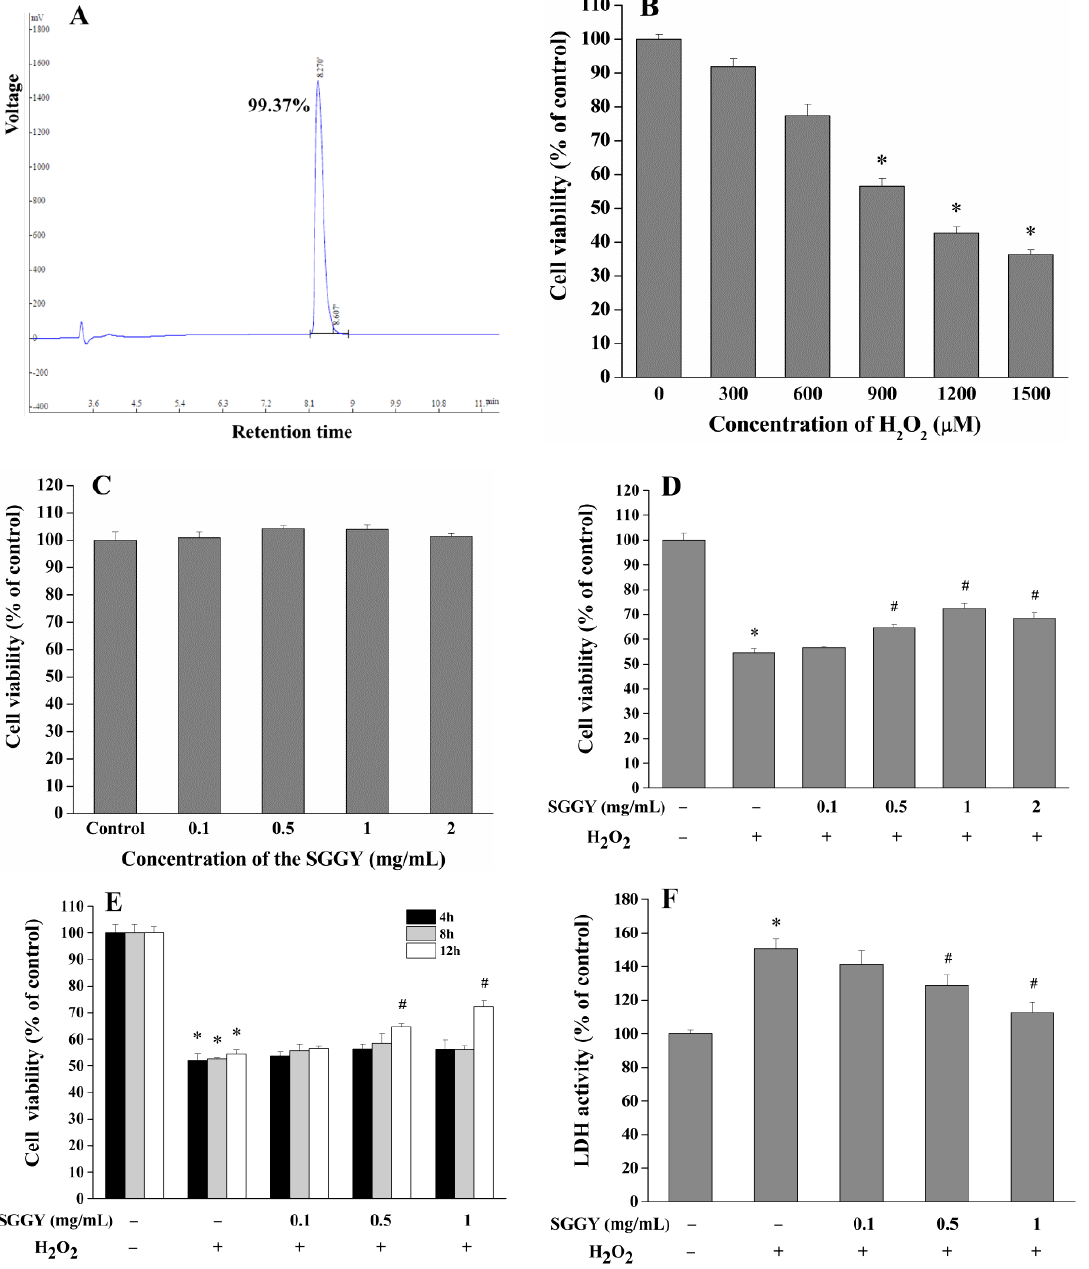
Figure 1. SGGY suppressed H 2 O 2 -triggered cytotoxicity in SH-SY5Y cells. ( A ) Purity of SGGY. Cells were treated for 2 h with ( B ) various concentrations of H 2 O 2 , or for 12 h with ( C ) different concen- trations of SGGY, and subsequently, the cell viability was determined using the MTT assay. Cells were pre-incubated with ( D ) various concentrations of SGGY for 12 h or ( E ) indicated concentrations of SGGY for various times, and subsequently exposed to 900 μ M H 2 O 2 for 2 h followed by a deter- mination of the cell viability. ( F ) Cells were pre-incubated with indicated concentrations of SGGY for 12 h, and subsequently exposed to 900 μ M H 2 O 2 for 2 h; the leakage of LDH was measured by a LDH detection kit. * p < 0.05 vs. control group, and # p < 0.05 vs. H 2 O 2 group.